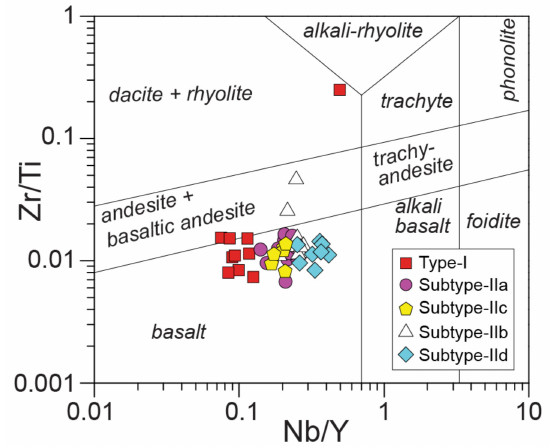
Figure 8. Nb / Y vs. Zr / Ti discrimination diagram of Winchester and Floyd [74], modified by Pearce [75] for subvolcanic and volcanic rocks from the sheeted dyke complex and volcanic sequence of the Band-e-Zeyarat